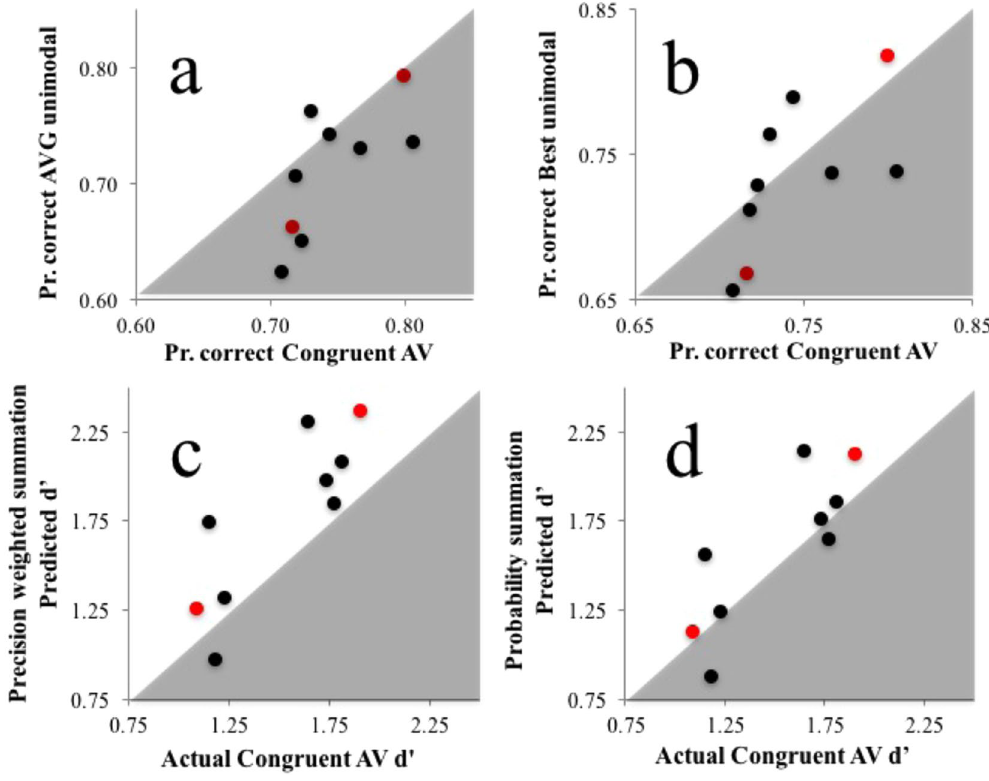
Figure 5. Data from Experiment 2. ( a ) X/Y scatterplot of individual proportion correct task performance scores on Congruent AV trials (X axis) and proportion correct scores averaged across each individuals’ unimodal visual and auditory trials (Y axis). ( b ) As for ( a ) but for the best of each individuals’ two types of unimodal trials (Y axis). ( c) ( c ) X/Y scatterplot of individual d’ scores for Congruent AV trials (X axis) and d’ scores predicted by a precision weighted summation, from performances on unimodal trials. ( d ) As for ( c) , but for d’ scores predicted by probability summation. In all plots author data points are coloured red. Data points in grey regions of ( a , b ) indicate better performance on Congruent AV trials, relative to the other dataset. Data points in white regions in ( c , d ) indicate worse performance on congruent AV trials than